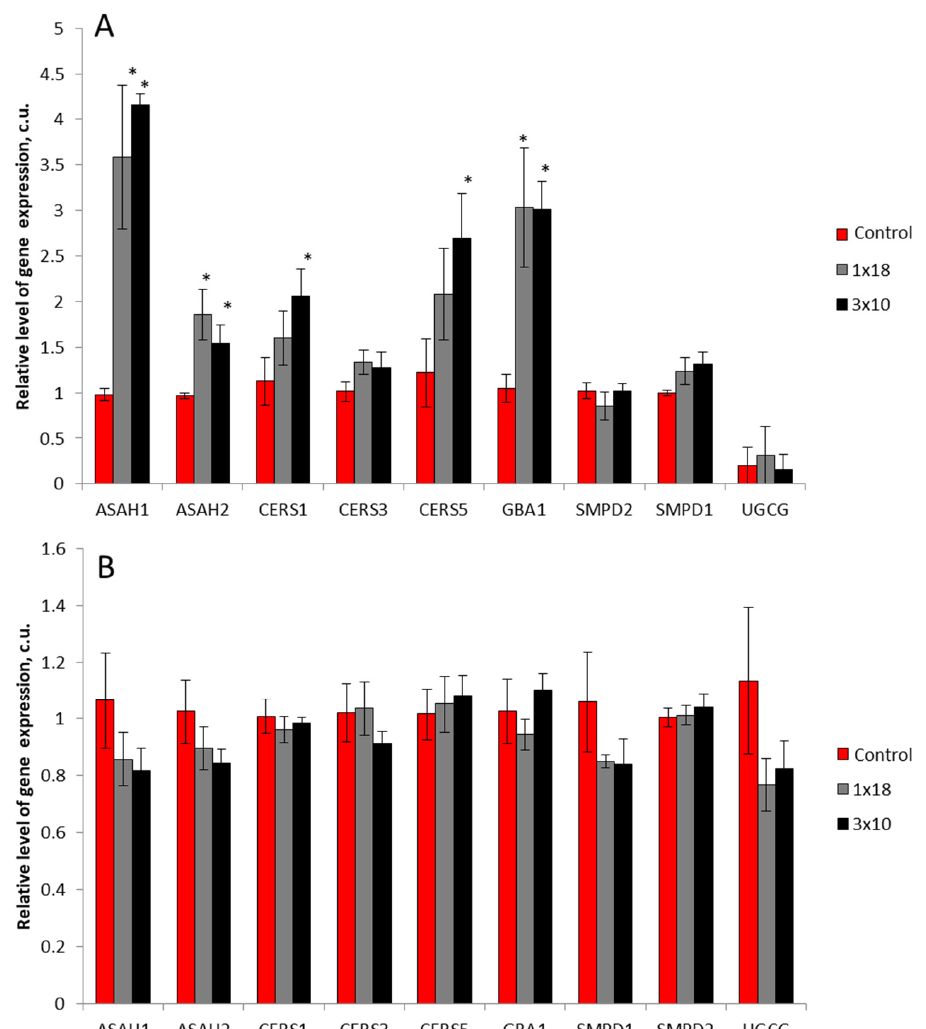
Figure 8. Relative level of gene expression in the substantia nigra ( A ) and in the striatum ( B ) in mice 2 weeks after the administration of 1-methyl-4-phenyl-1,2,3,6-tetrahydropyridine (MPTP): once at a single dose of 18 mg/kg (1 × 18) or three times at a single dose of 10 mg/kg (3 × 10), with a 2-h interval between injections, as well as after saline administration in the controls. ASAH1, acid ceramidase; ASAH2, neutral ceramidase; CERS1, CERS3, CERS5, ceramide synthases 1, 3, and 5, respectively; GBA1, glucocerebrosidase; SMPD1, sphingomyelin phosphodiesterase 1 (acid sphingomyelinase); SMPD2, sphingomyelin phosphodiesterase 2 (neutral sphingomyelinase); UGCG, ceramide glucosyltransferase. * p < 0.05, significant differences between the experiment and the controls.